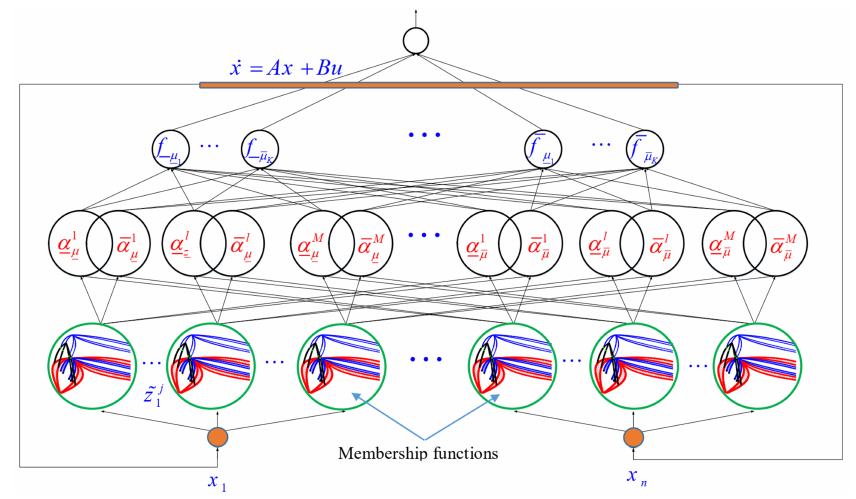
Figure 2. The structure of